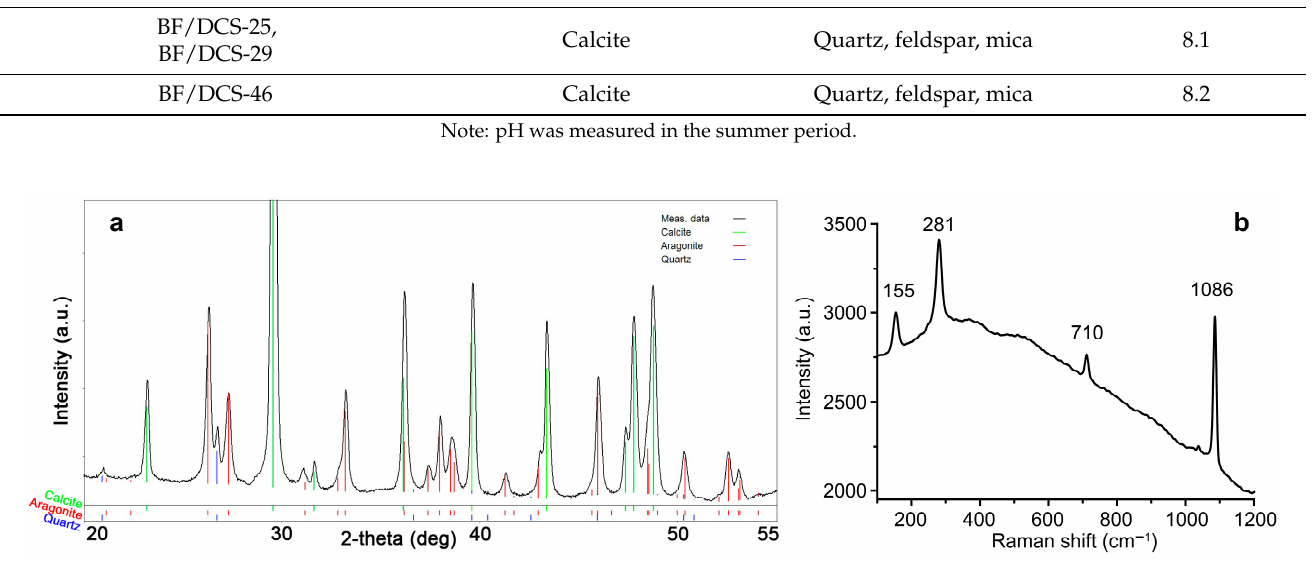
Figure 3. Examples of X-ray diffraction pattern ( a ) and Raman spectra ( b ) of carbonates: a—magnesium calcite and aragonite; ( b )—calcite. Table 2. Mineral composition of water deposits and pH of water.